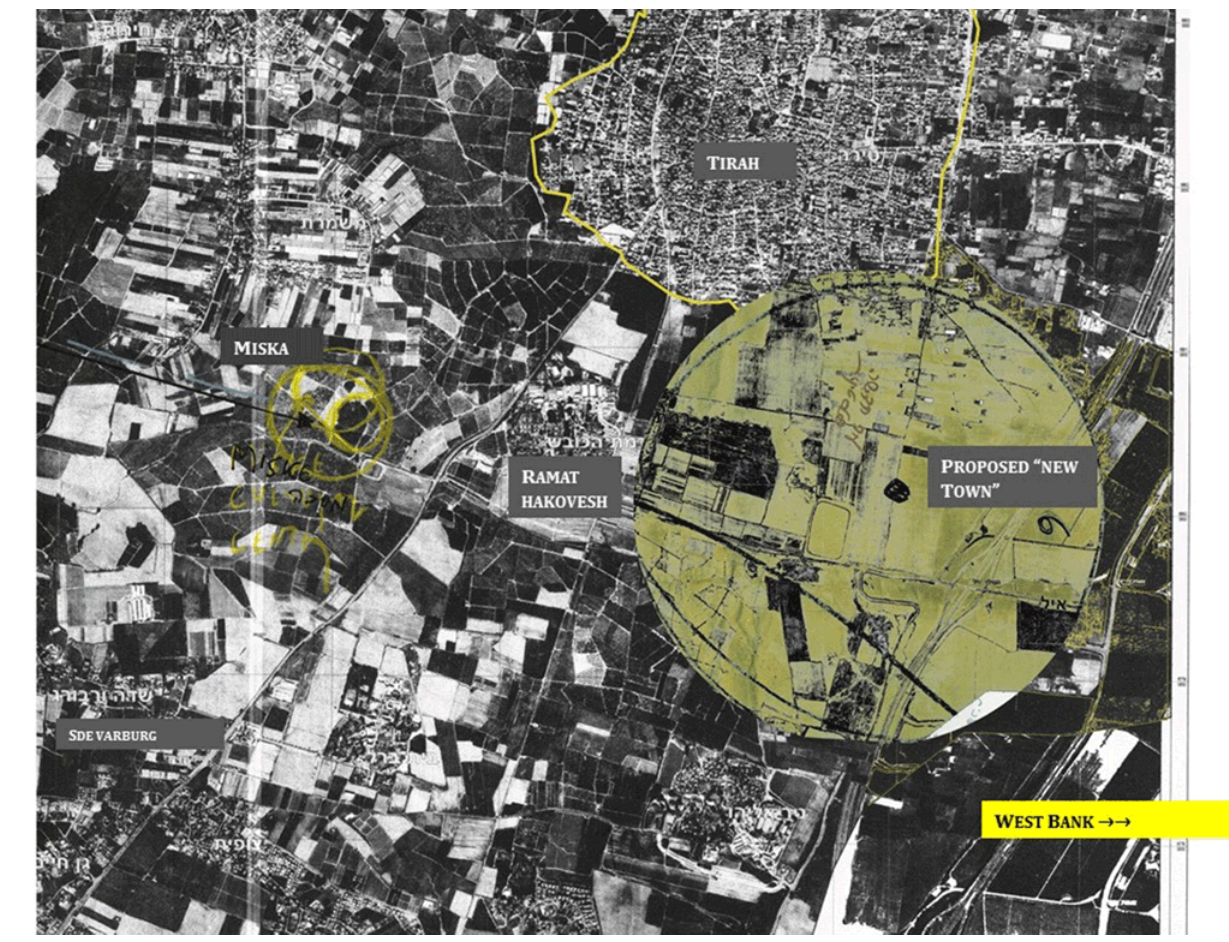
Figure 4. Day 2: Intermediate proposal: land-use . Large yellow circle signifies a proposed “new Palestinian town” adjacent to the Arab-Israeli town of Tira. The smaller yellow circle marks the location of historical Miska, where the team proposed a conservation plan of the old